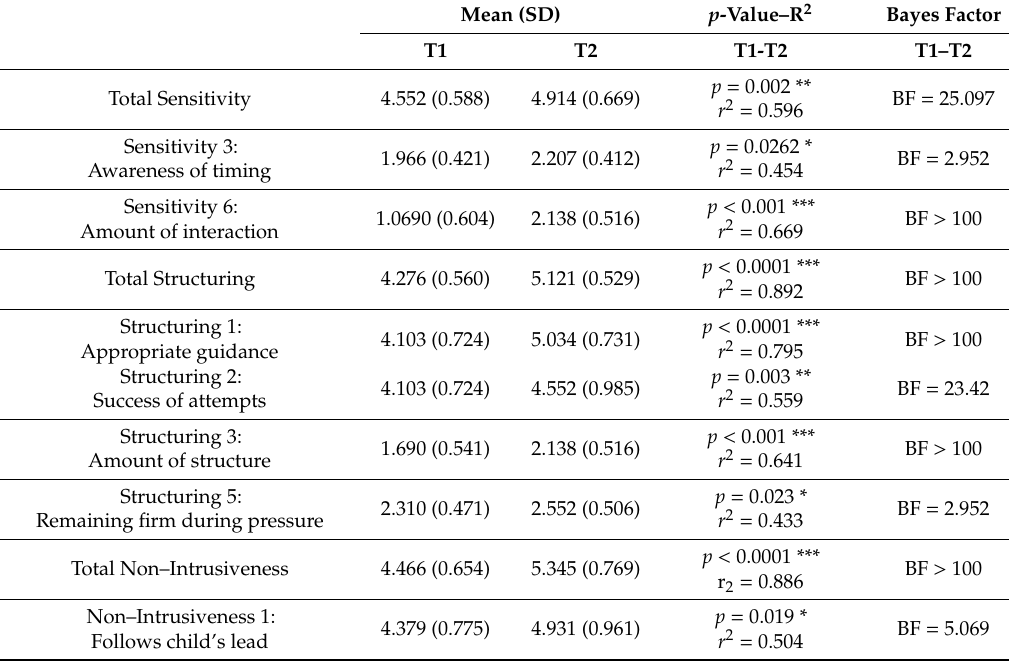
Table 4. Descriptive and Inferential Statistics of Adult Emotional Availability Scales-Main Scales and